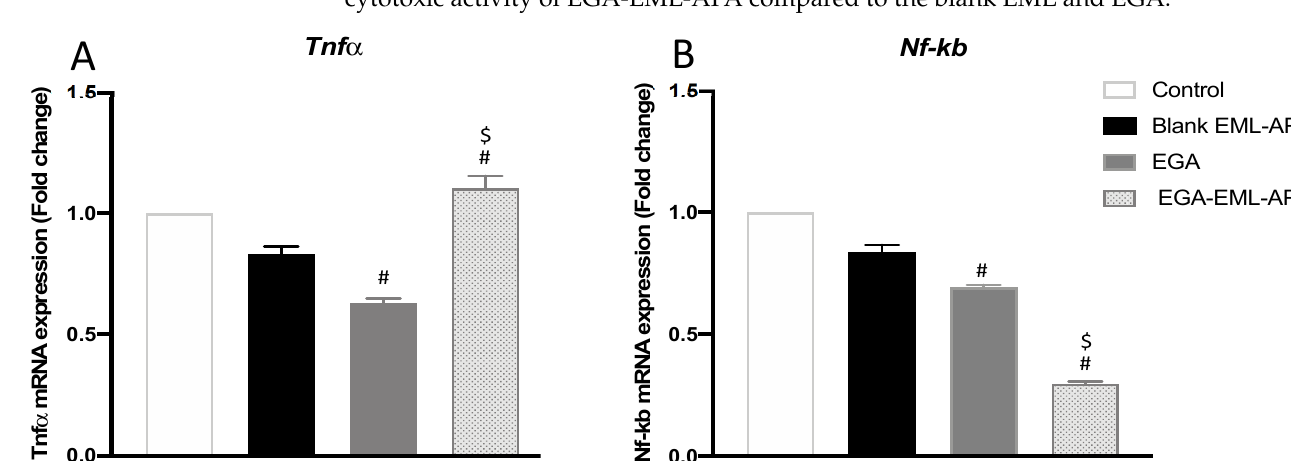
Figure 12. Effect of the optimized EGA-EML-APA formula on the expression of tnf- α ( A ) and nf- κ b ( B ) in MCF-7 cells. Data are presented as Mean ± SD (n = 3). # or $: Statistically different from blank EML-APA or EGA, respectively, at p < 0.05. Abbreviations: EGA, ellagic acid; EML, emulsomes; APA, apamin.